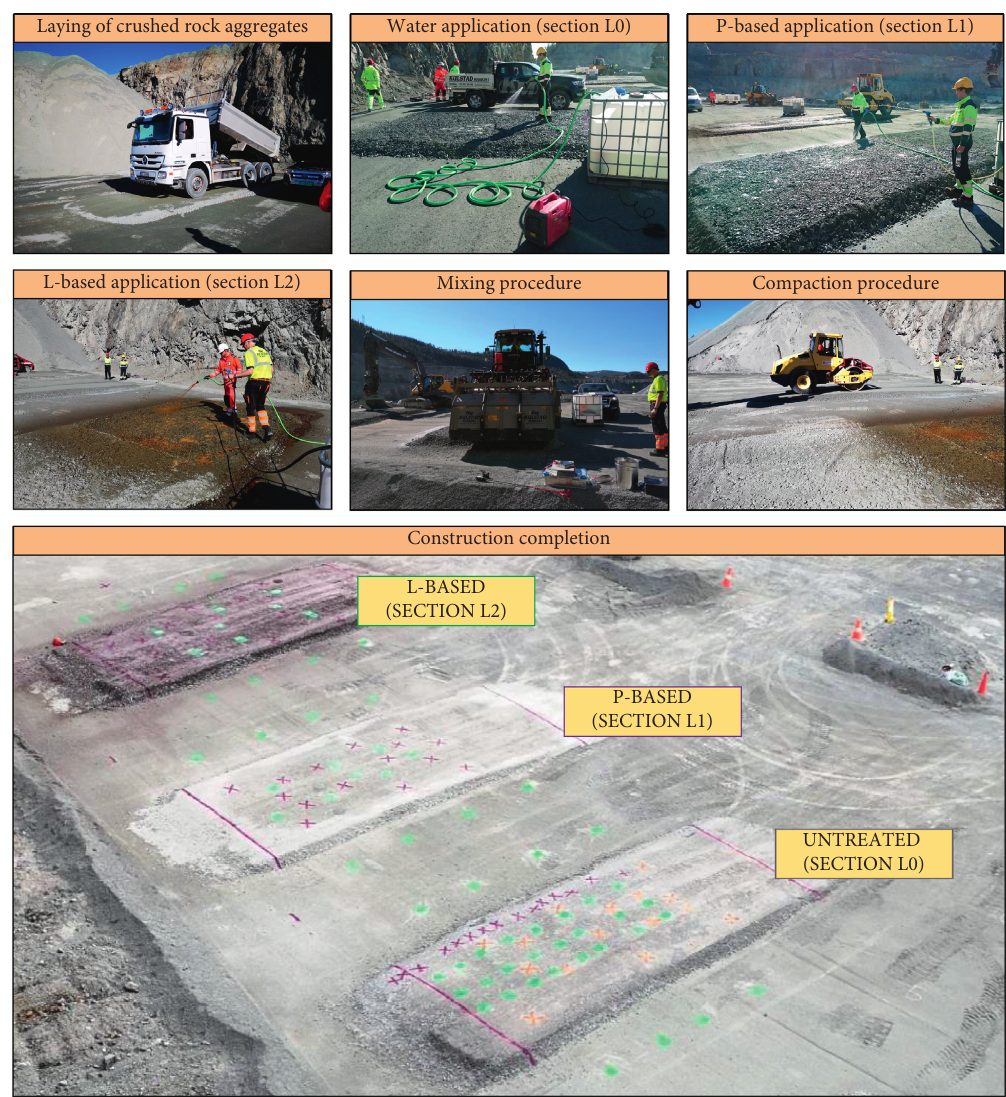
Figure 5: Main stages of the construction operations to build the road rest sections. Table 4: Quantity of admixtures used in each